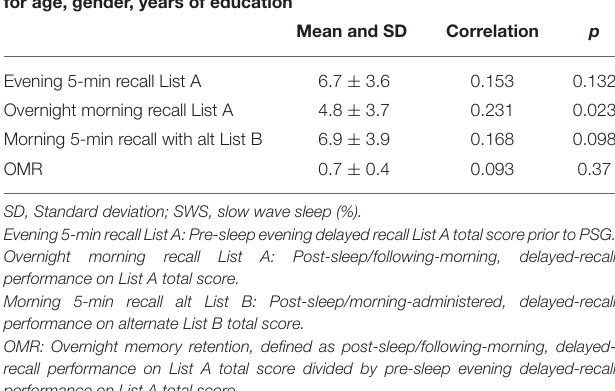
TABLE 2 | Mean, standard deviation, and partial correlation analysis to examine the association of SWS and list-learning scores covaried for age, gender, and year of education and correlation coefficient. All 101 participants, partial correlation with SWS, covaried for age, gender, years of education